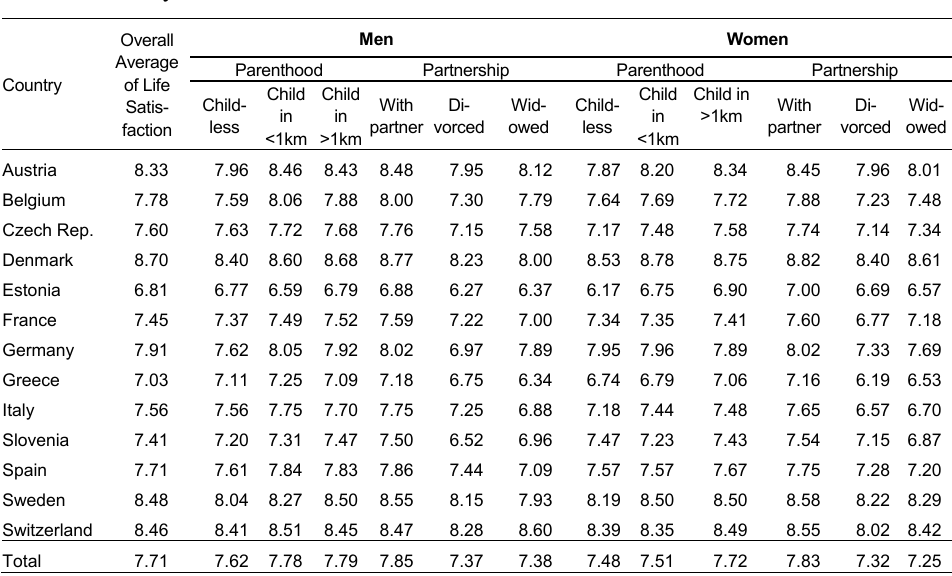
Table 1 : Average life satisfaction by partnership and childlessness for men and women for the pooled sample and across 13 European countries. Individuals aged 50- 85